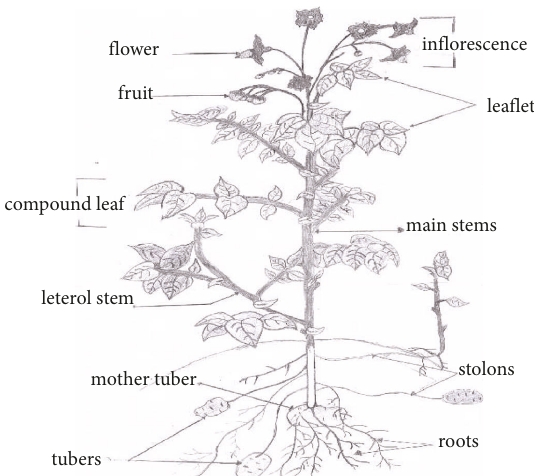
Figure 1: An annotated diagrammatic presentation of a matured potato plant ( Solanum tuberosum L)